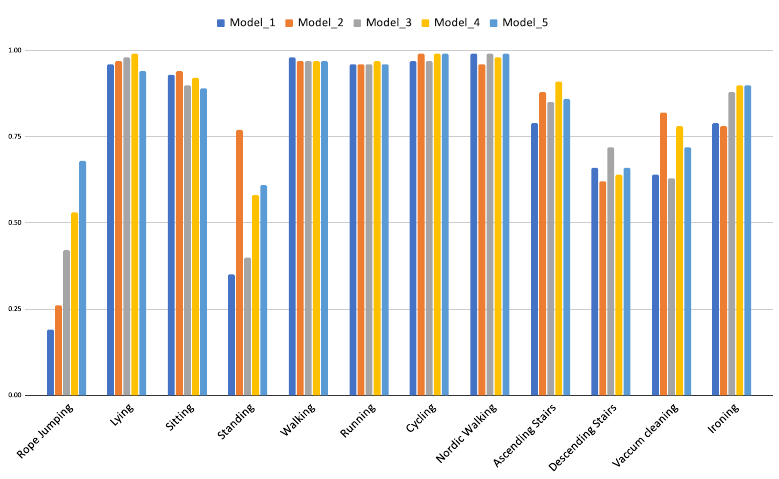
Figure 10. F1-score of activities per model that are trained on different window sizes in DTE using LSTM architecture for PAMAP2